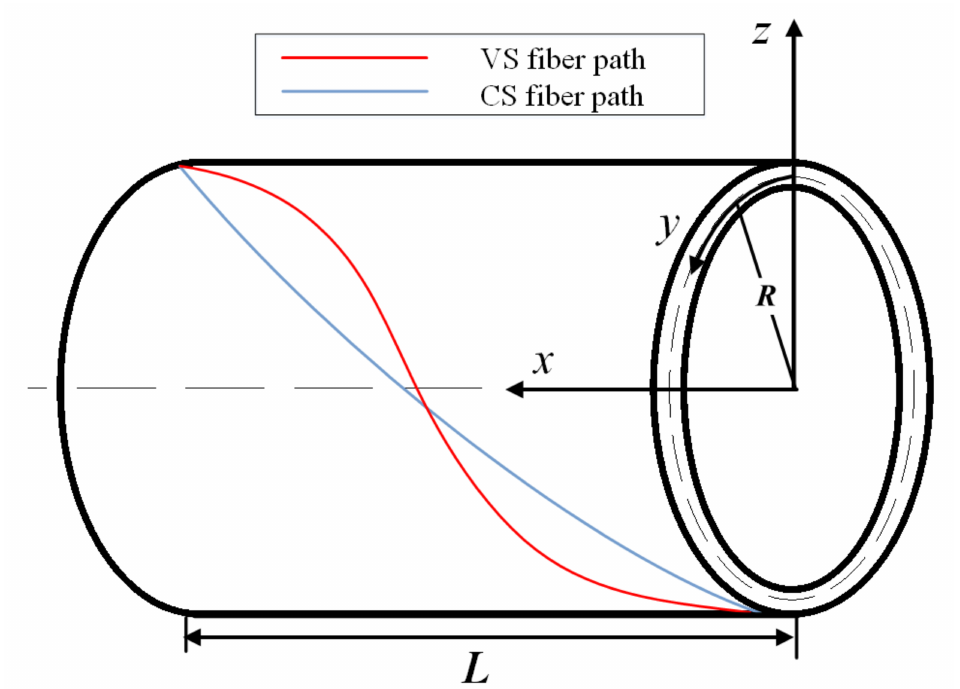
Figure 2. A cylindrical